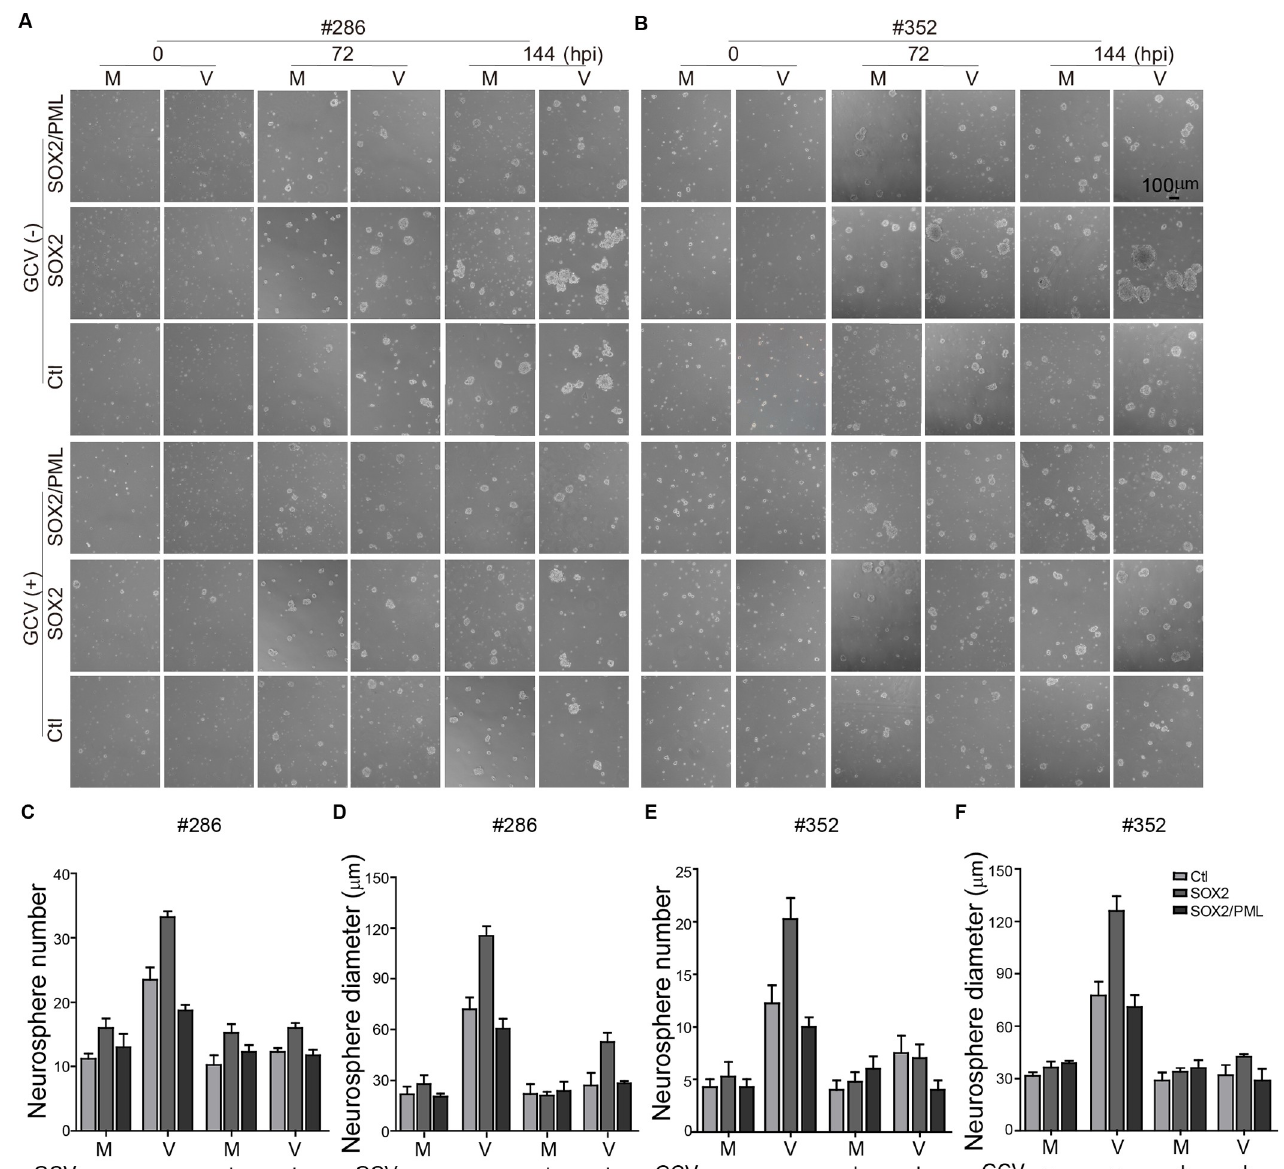
Fig 5. Effects of SOX2 overexpression and HCMV infection on neurosphere formation of GSCs. Patient-derived GSCs (#286 and #352) were transduced with SOX2 (SOX2), SOX2 and PML (SOX2/PML) or control lentivirus (Ctl). The transduced GSCs cultured in 48-well plates (2 x 10 5 /well) were mock-infected (M) or infected by HCMV Towne strain (V) at an MOI of 5, and a few wells were treated with 150 μ M ganciclovir (GCV) for 48 hours. Representative images of spheres formed by GSC #286 ( A ) and GSC #352 ( B ) are shown. Quantification of neurospheres (number/field and size) at 144 hpi is shown in ( C - D ) for GSC #286 and ( E - F ) for GSC #352. Number and size of neurospheres were measured in random independent fields per well and three wells were included. Data are from three independent experiments and represent as means ± SEM. Two-way ANOVA analyses along with the Tukey post-hoc multiple comparisons were performed to evaluate the statistically significant differences between groups ( C - F ), and the p-values and statistical parameters are provided in Tables A-D in S1